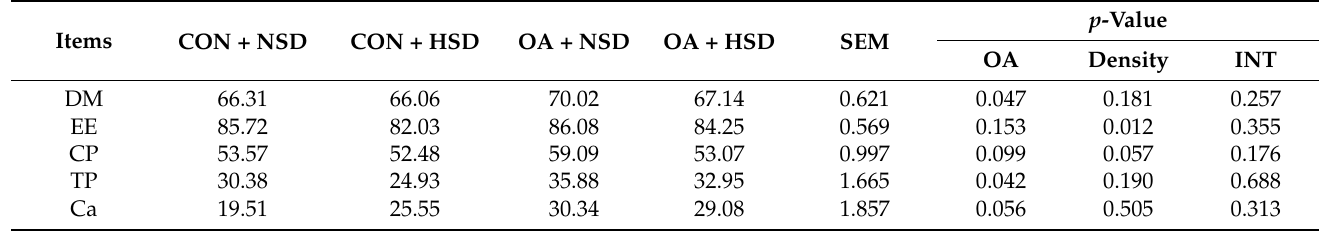
Table 5. Effects of organic acids on nutrient digestibility in broilers under high stocking density in the grower phase (%) 1 .